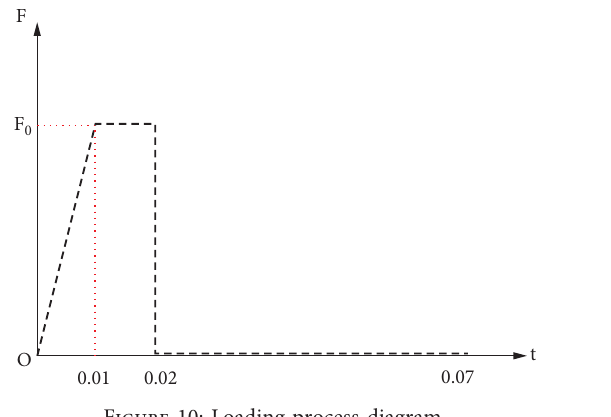
Figure 10: Loading process diagram.